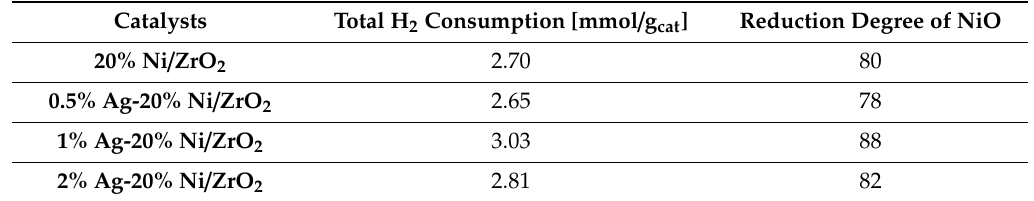
Table 6. Hydrogen consumed during the temperature programmed reduction run and the estimated reduction degree for the nickel and bimetallic catalysts.